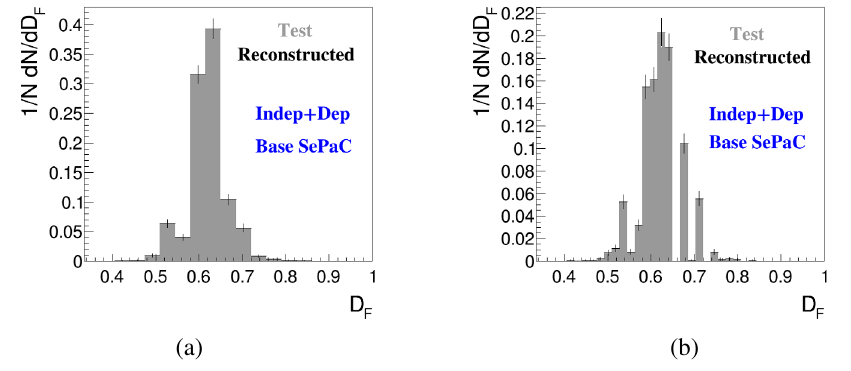
Figure 2. The event distribution by dimension D F for independent and dependent fractals (gray area) and reconstructed distribution using the base SePaC method (black cross) at various bin width